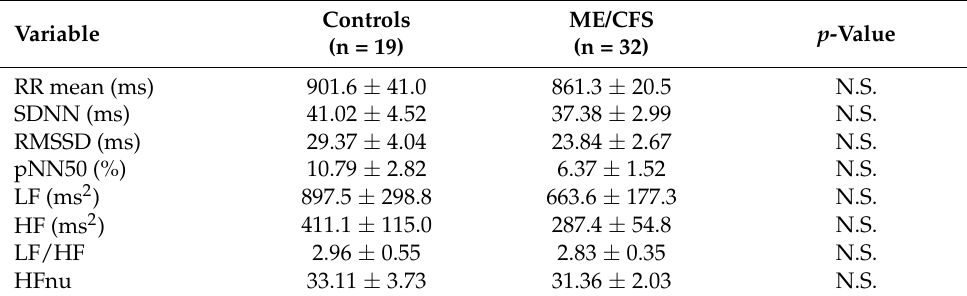
Table 2. HRV parameters among participants (men).